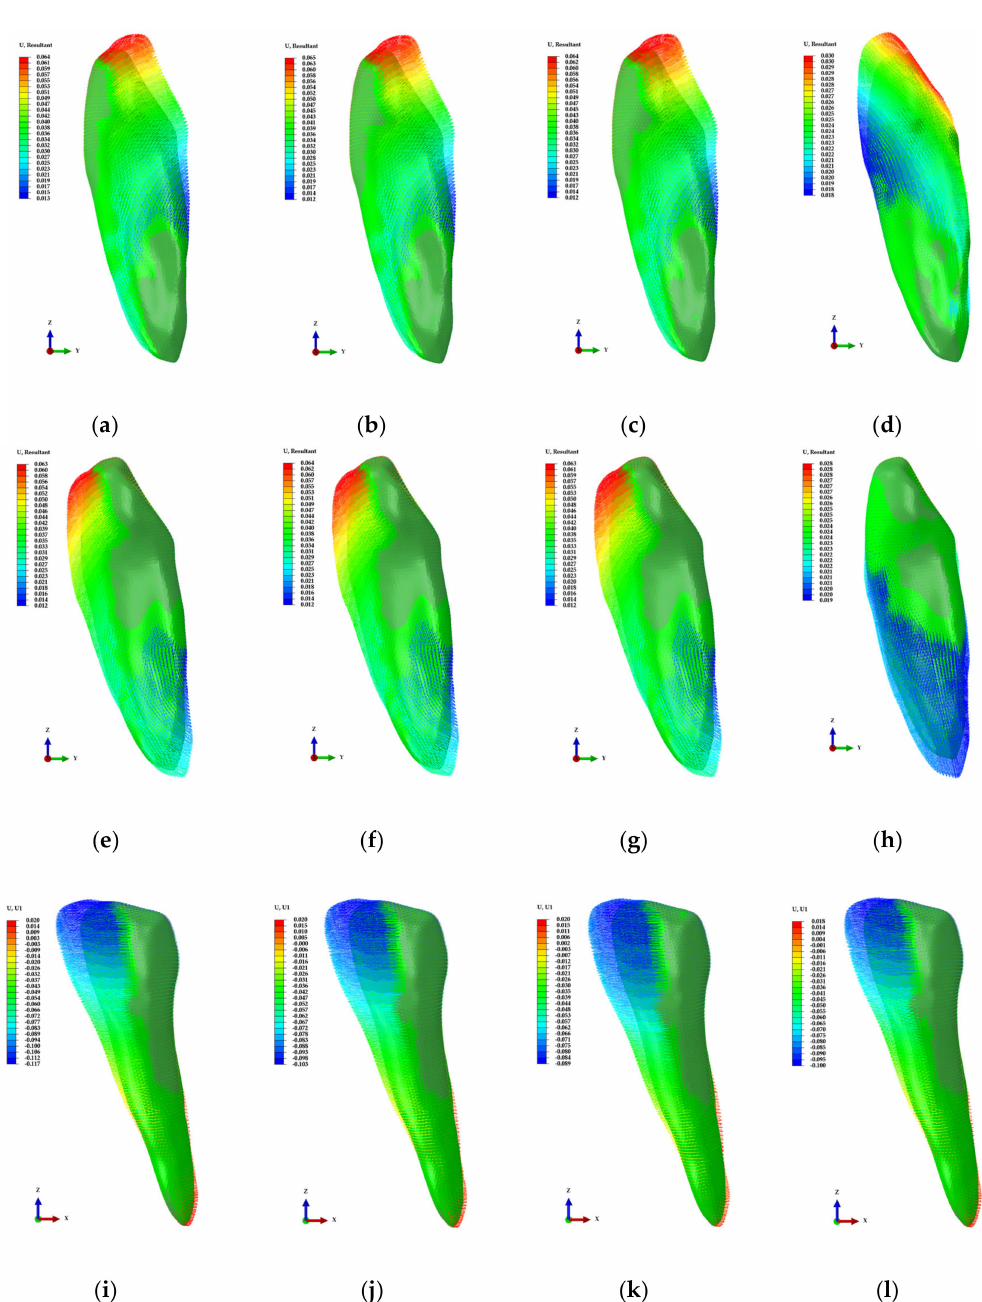
Figure 10. The displacement distribution of the teeth in various attachment models. ( a ) upper position; ( b ) middle position; ( c ) lower position in buccal side of the teeth; and ( d ) lower position in lingual side of the teeth for the extrusion attachment; ( e ) upper position; ( f ) middle position; ( g ) lower position in buccal side of the teeth; and ( h ) middle position in lingual side of the teeth for the intrusion attachment; ( i ) upper position; ( j ) middle position; ( k ) lower position in buccal side of the teeth; and ( l ) upper position in lingual side of the teeth for the torque